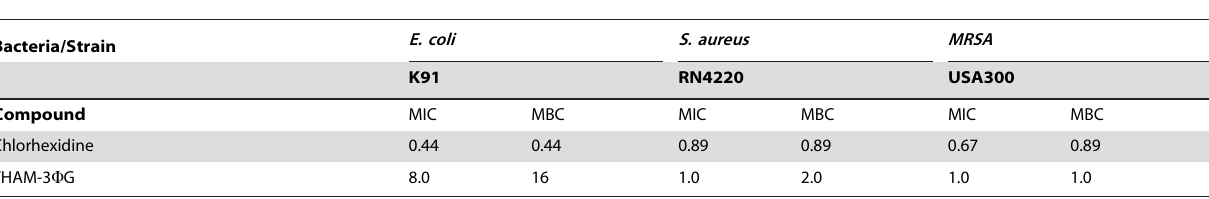
Table 2. Median MICs and MBCs for chlorhexidine and THAM-3 W G in MHB.